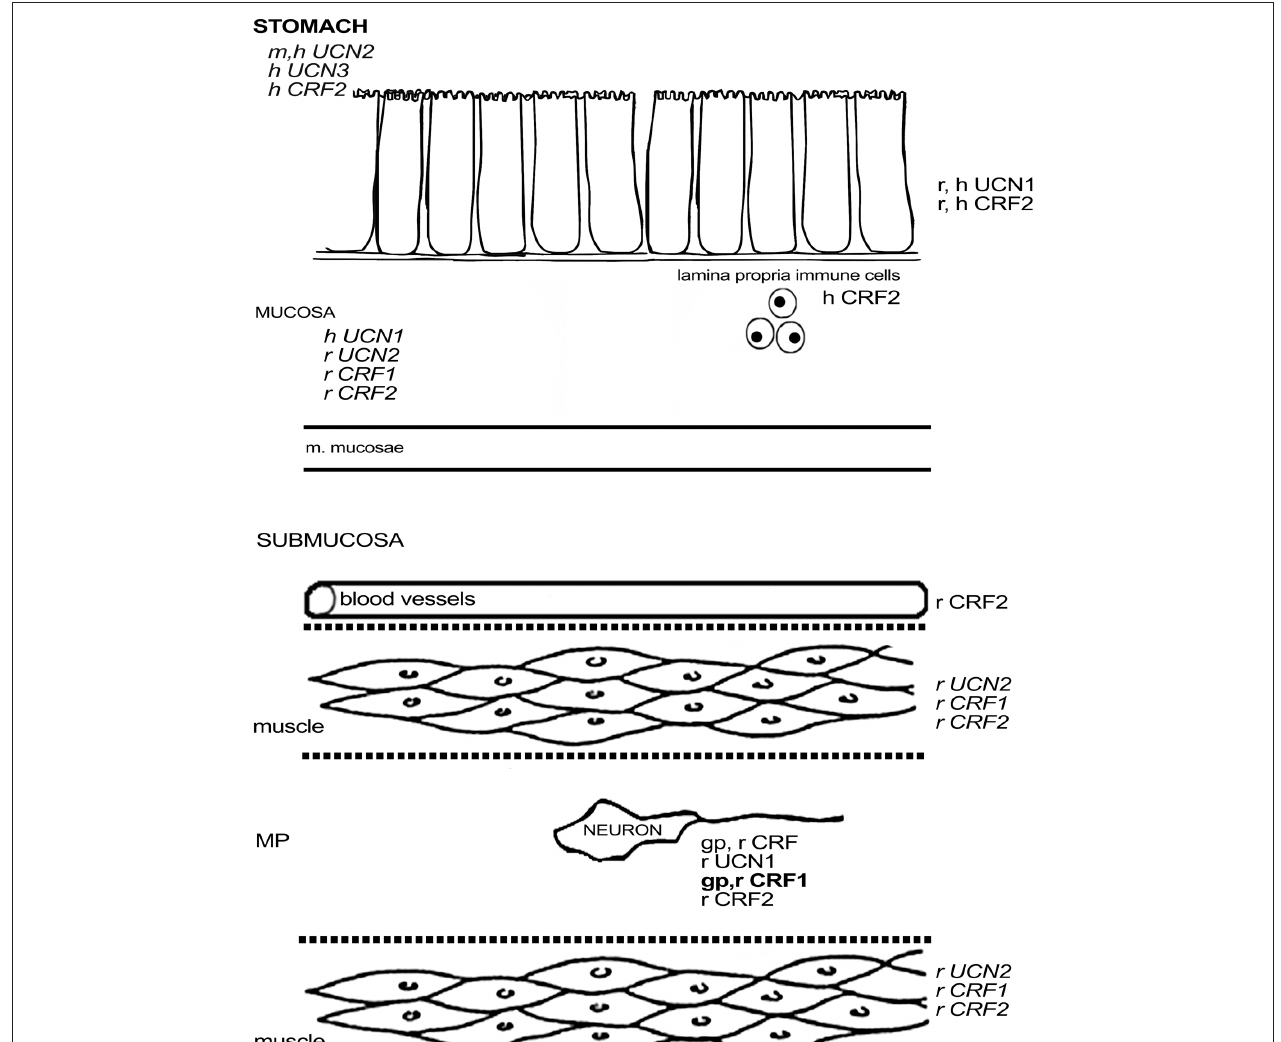
Figure 1 | Schematic overview of the expression of CrF-related proteins in the stomach. Regular font indicates that protein expression has been described, italic font indicates that mRNA expression has been described, bold